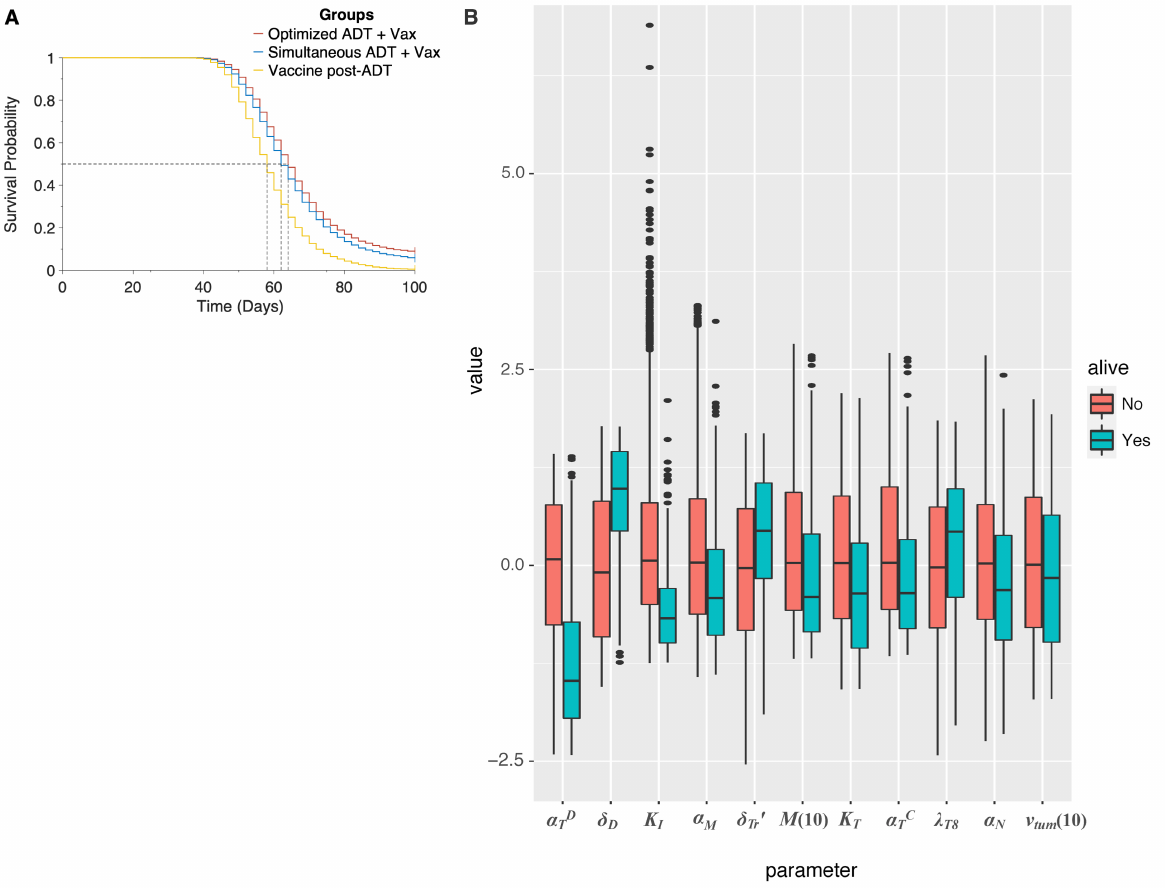
Figure 6. ( A ), Overall survival of simulated mice from time of combination treatment initiation, on various schedules. ( B ) Box plot of parameter values in simulated mice, giving median and inter-quartile range. Parameters are normalized to mean and standard deviation across all simulated mice. Only those parameters are represented that were found to be significantly associated with a cure (tumor size 1 mm 3 ) when ADT and vaccination are administered as a combination, on the optimal schedule predicted by the model. Red boxes correspond to dead mice, and teal boxes correspond to cured